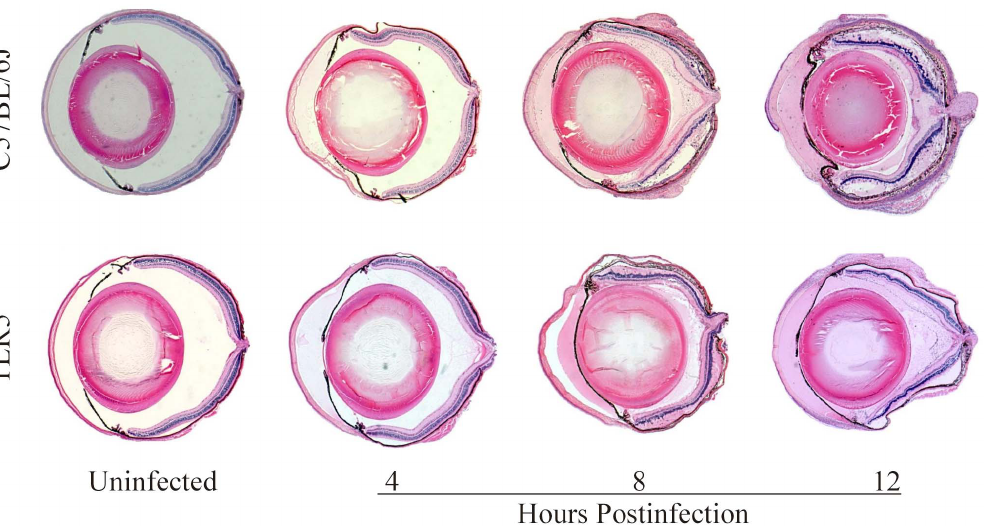
Figure 3. Whole eye histology of experimental B.cereus endophthalmitis. C57BL/6J and TLR5 2 / 2 mouse eyes were injected with 100 CFU B. cereus . Whole globes were harvested and processed for hematoxylin and eosin staining. Infected eyes of both groups had significant inflammation by 12 h postinfection, suggesting that the absence of TLR5 did not greatly impact intraocular inflammation. Sections are representative of 4 eyes per group. Magnification, 10X.